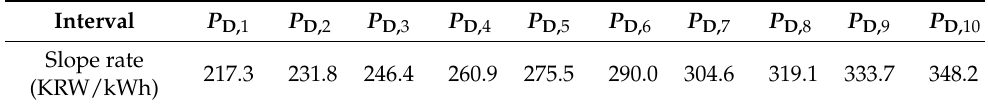
Table 1. Slope rate of each diesel generation interval